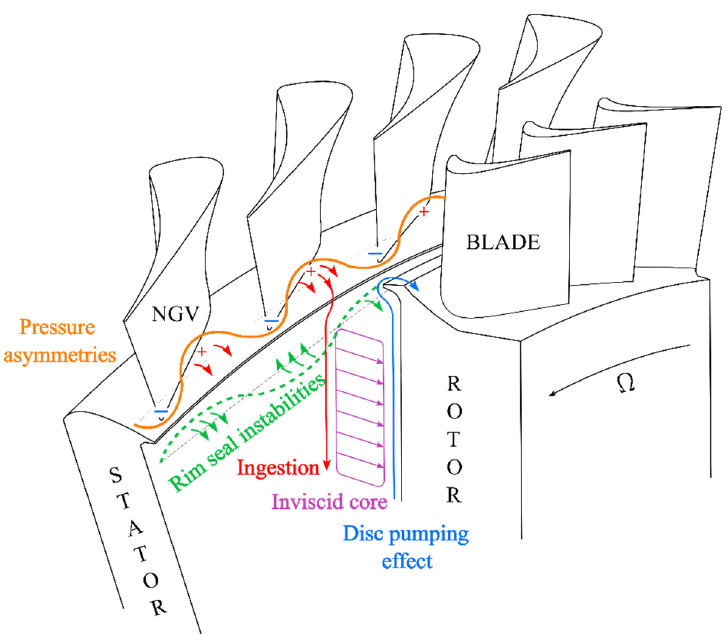
Figure 1. Driving mechanisms for hot gas ingestion.